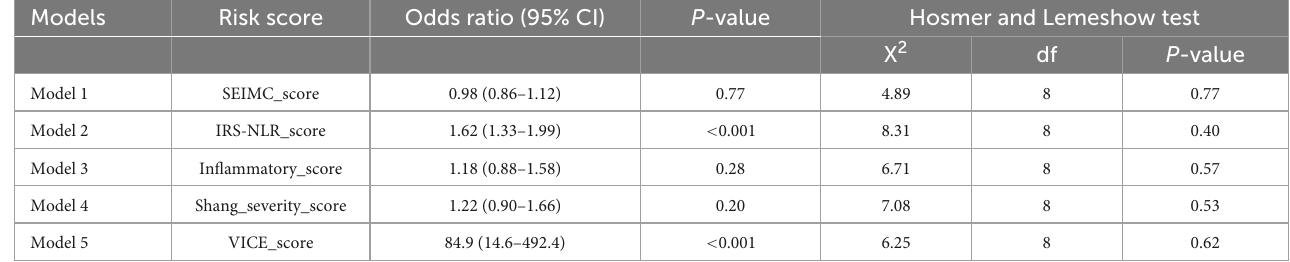
TABLE 5 Models of predictors of ventilation